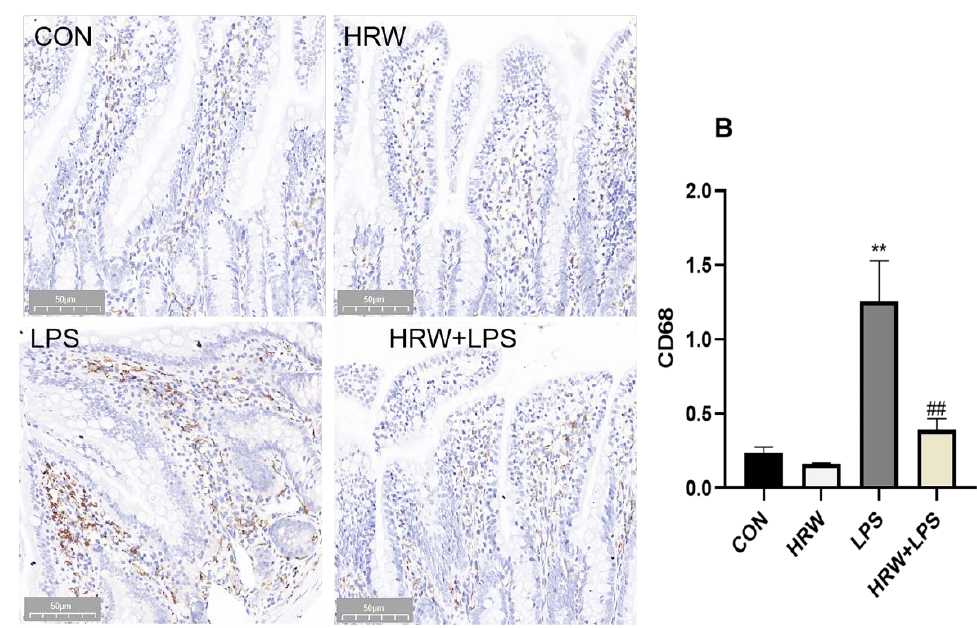
Figure 3. Effects of HRW on macrophage infiltration in rats with chronic gut inflammation. ( A ) Immunohistochemical analysis of macrophages in ileal tissue (200 × ). (B) Quantitative anal- ysis of CD68 in ileum tissue. **, ## p <